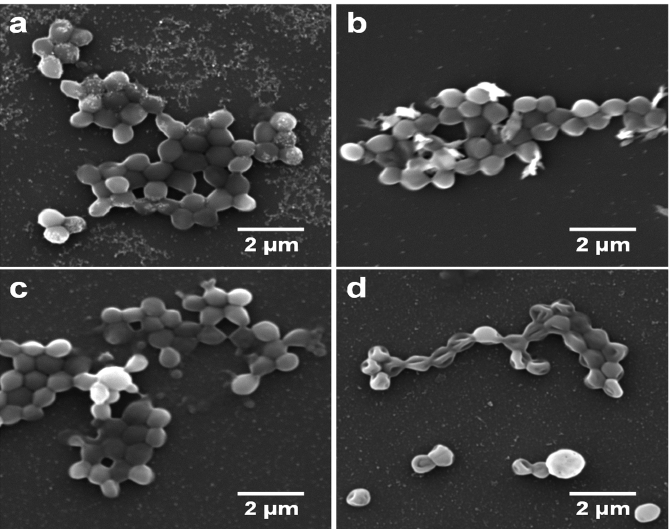
Figure 8. Morphology changes by CuO NPs and AQ. SEM images of S. aureus ATCC 25923 cells: ( a ) control, ( b ) CuO NPs (MIC), ( c ) AQs (MIC), and ( d ) CuO NPs/AQ at the synergistic level. Overnight grown cells were treated for 3 h with samples and imaged. One of the representatives is shown ( n = 3).